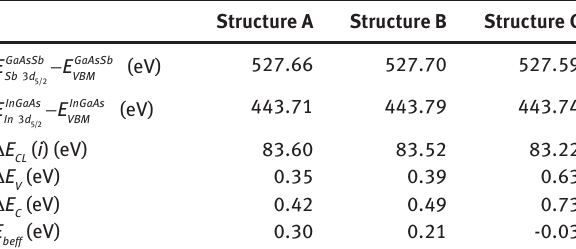
Table 4 Summary of core level to valence band maxima binding energy difference (eV) for GaAsSb and InGaAs, and the binding energy difference between Sb3d ( Δ E ( i )) from the three structures a CL